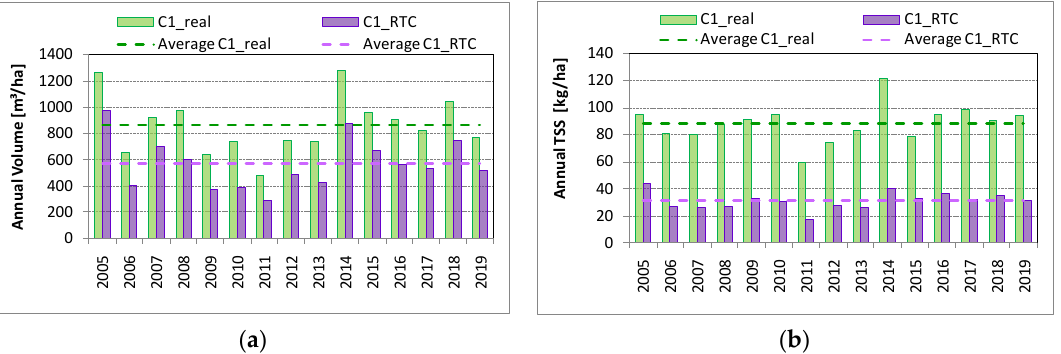
Figure 9. Annual specific runoff volume ( a ) and specific total suspended solids (TSS) ( b ) spilled by the CSO into the receiving water body under C0 (benchmark scenario) and C1 (benchmark scenario + RTC) scenarios.